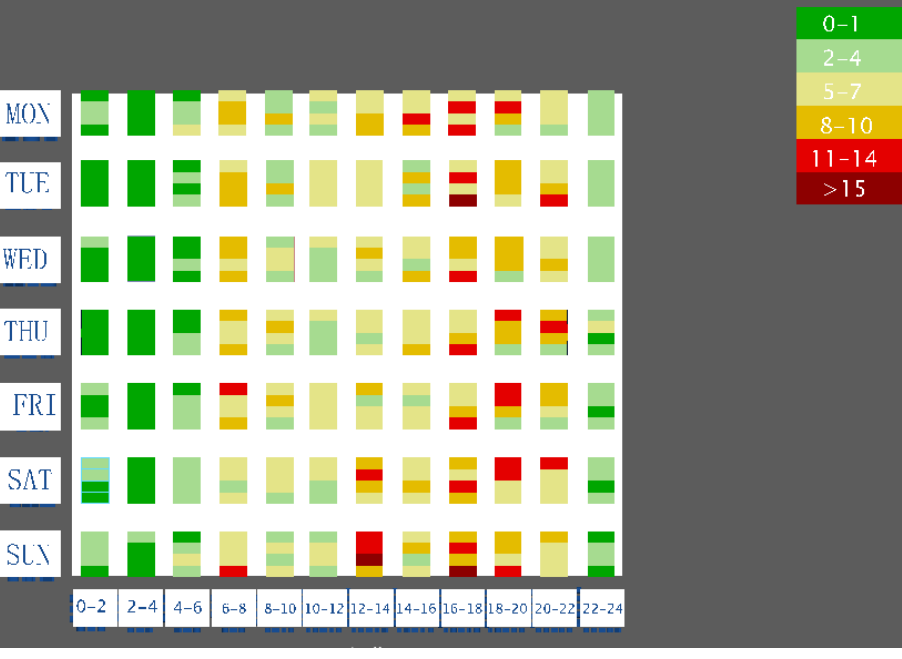
Figure 21 Proposed method version 3- whole month [x-y